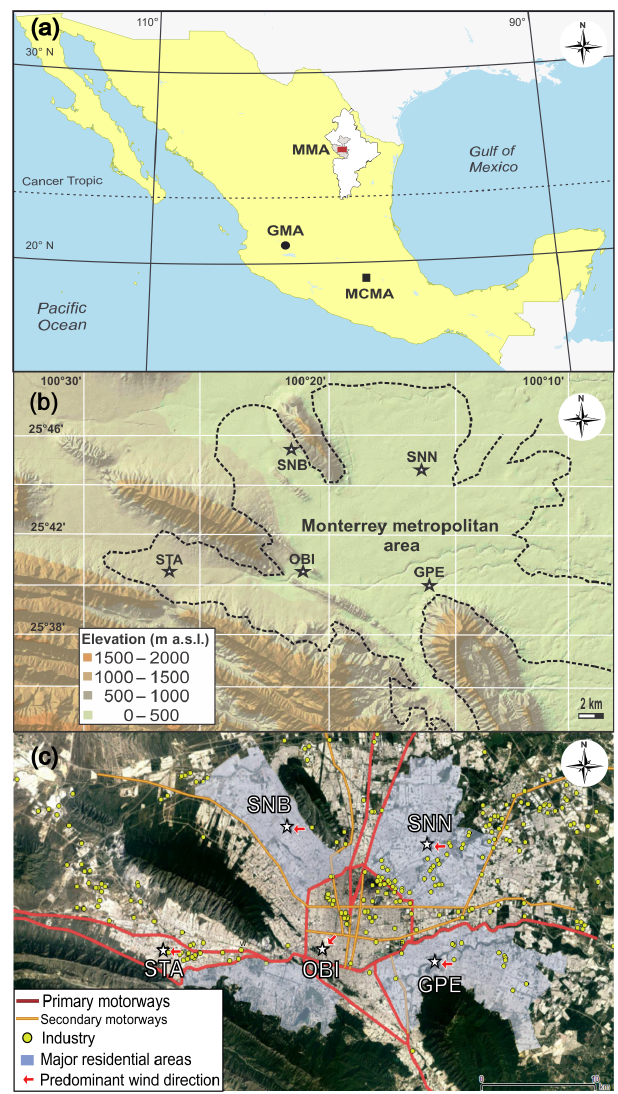
Figure 1. (a) The MMA, MCMA, and GMA in the national context. (b) Topography of the MMA and distribution of the five monitoring sites over the area. (c) The five monitoring sites in relation to pri- mary and secondary motorways, industries, and major residential areas. The red arrows show the predominant wind direction at each site from 1993 to